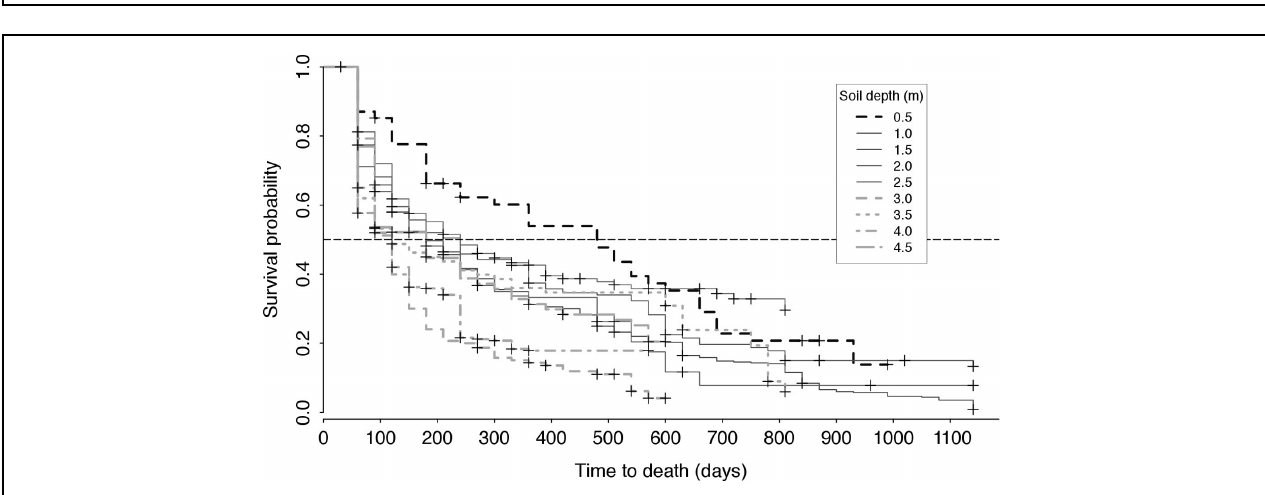
FIGURE 4 | (A) Box-whisker plot of root age distributions in each root window (for live and dead roots combined). (B) Distribution of the times of emergence of roots for each root window. The central vertical line indicates the median value, and the left and right edges of boxes (hinges) correspond to the 25th and 75th percentile values, while the whiskers extend 1.5 × beyond the spread of the hinges. Data points outside this range (outliers) are indicated with circles.